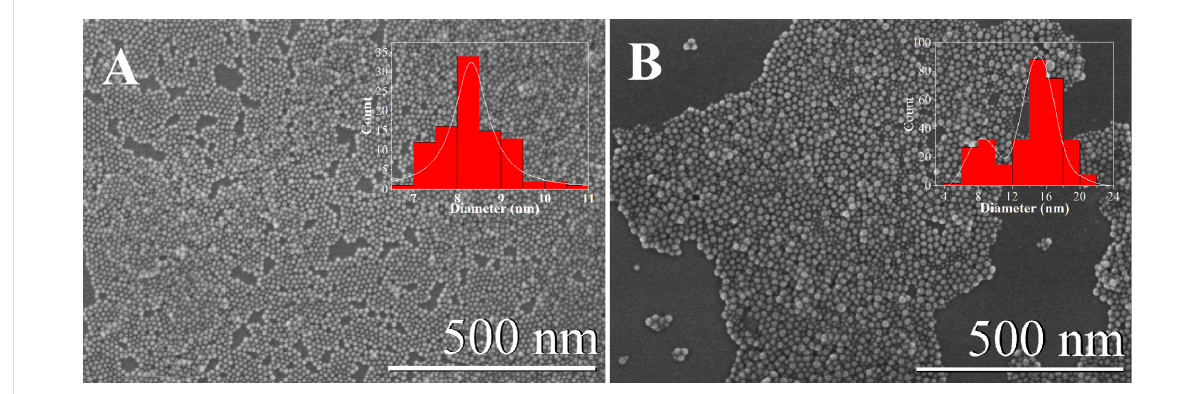
Figure 1: SEM images of the core NaGdF 4 :Yb,Er (A) and core@shell NaGdF 4 :Yb,Er@NaGdF 4 (B) nanoparticles. The insets display the UCNP diam- eter distributions.